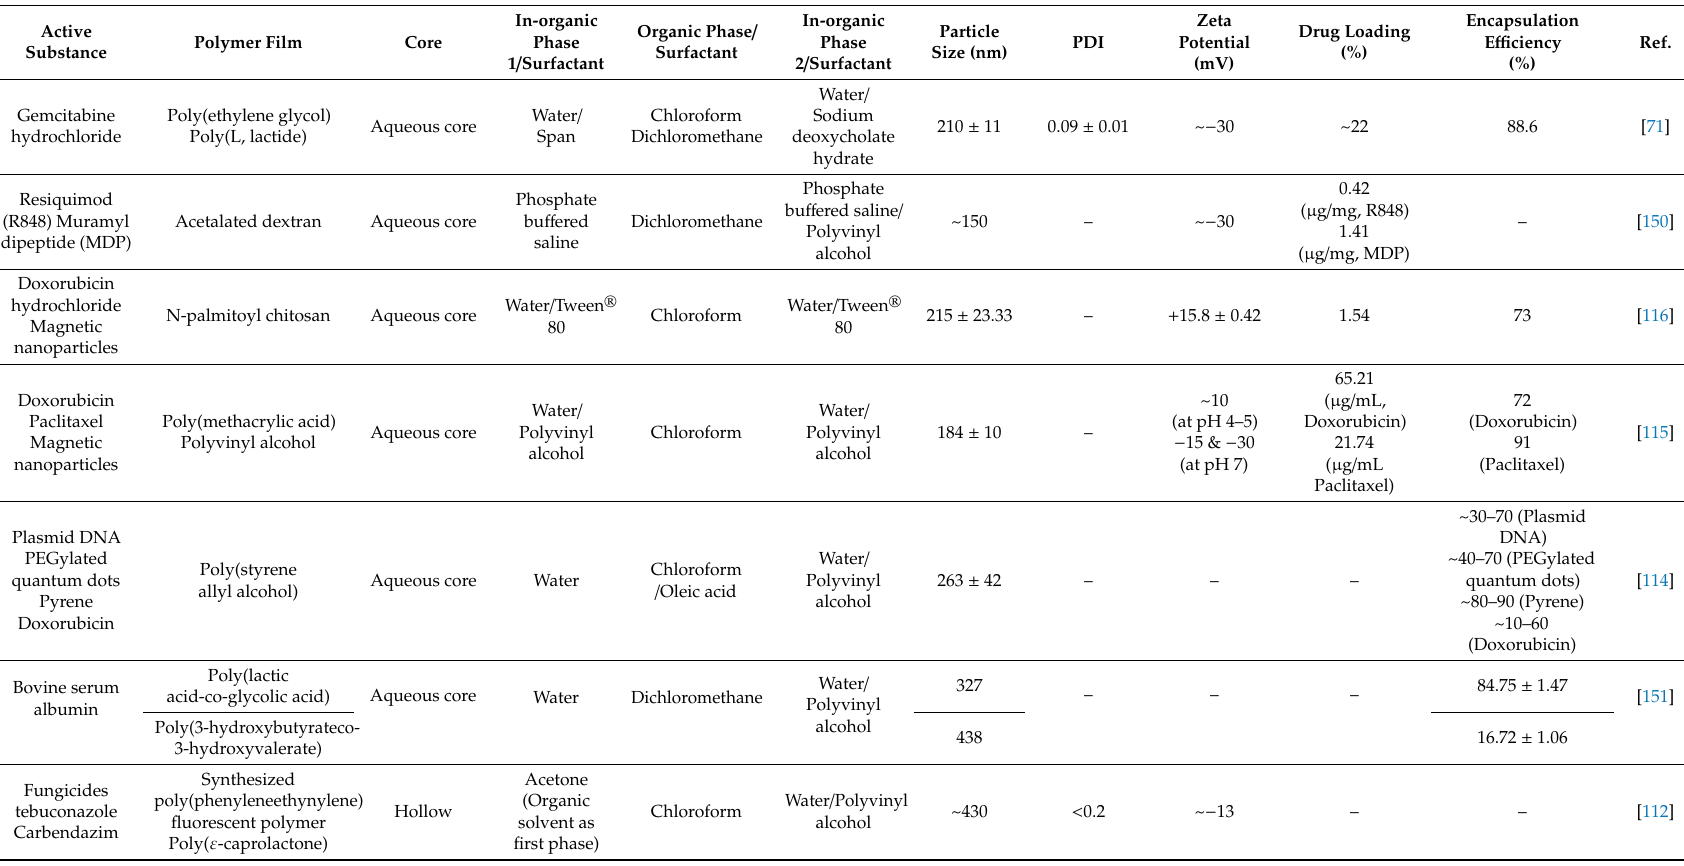
Table 4. Examples of polymeric nanocapsule formulation by double emulsion method in recent ten